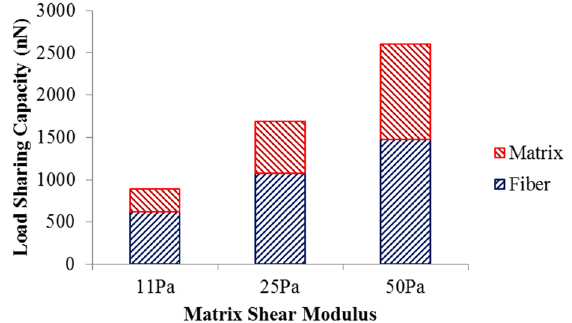
Figure 3. Load sharing capacity of scaffold.